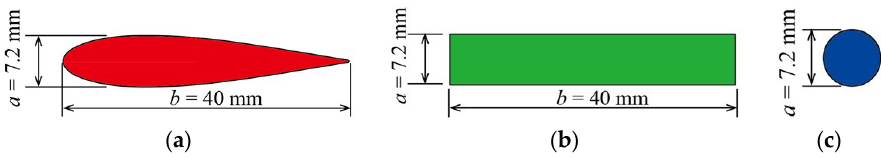
Figure 2. Arm cross sections: ( a ) NACA 0018 (two-dimensional drag coefficient: C D = 0.11), ( b ) rectangular ( C D = 0.97), and ( c ) circular ( C D = 1.2).